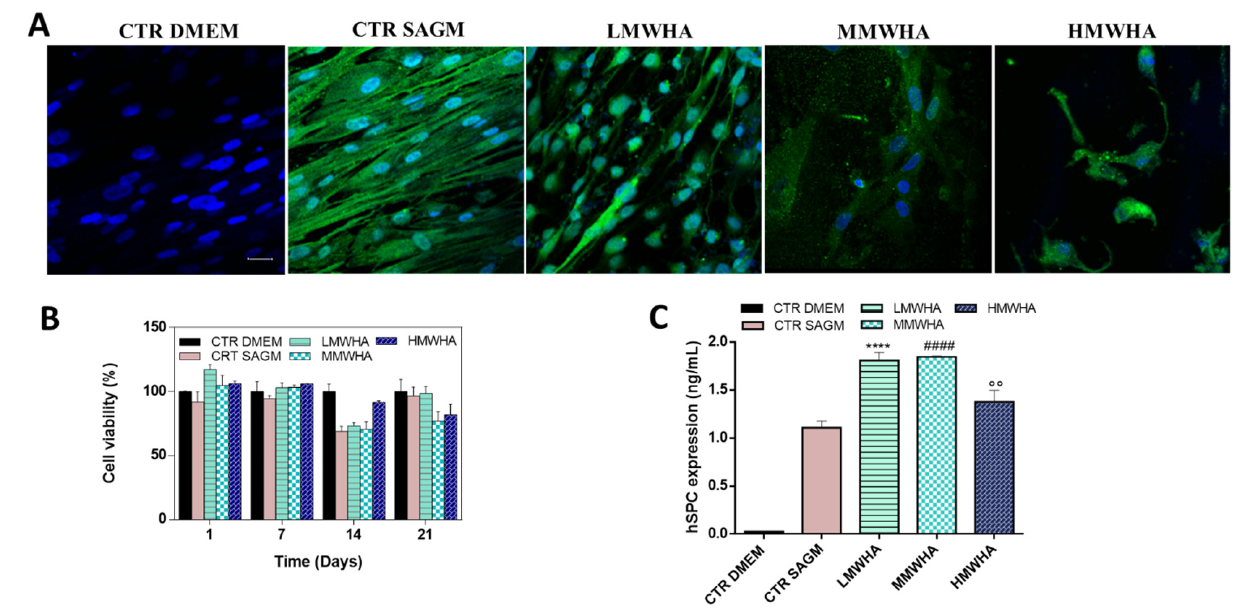
Figure 3. ( A ) Confocal images of Immunofluorescence staining of SPC in differentiated cells. Nuclei were stained with blue DAPI and positive expression of SPC (green) in the cytoplasm were assessed after 21 days of exposure with LMWHA, MMWHA, and HMWHA, excluded for the CTR DMEM. Scale bar: 50 µ m ( B ) Cell viability performed by Alamar blue test at 1, 7, 14, and 21 days of culture during the differentiation test ( C ) Quantitative expression of SPC performed by Elisa test. Results are mean ± of 3 experiments. **** p < 0.001 vs. Control SAGM, #### p < 0.001 vs. Control SAGM, ◦◦ p < 0.001 vs. Control SAGM.